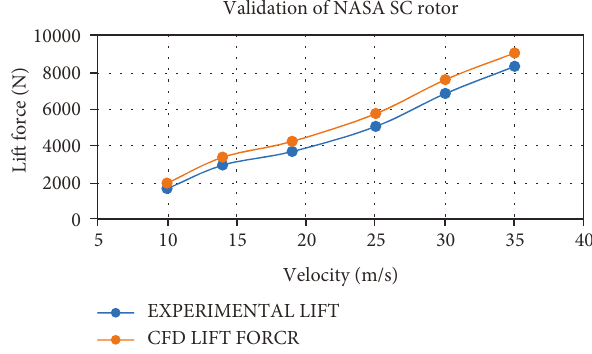
Figure 19: Validation of the NASA SC(2)-0714 rotor.